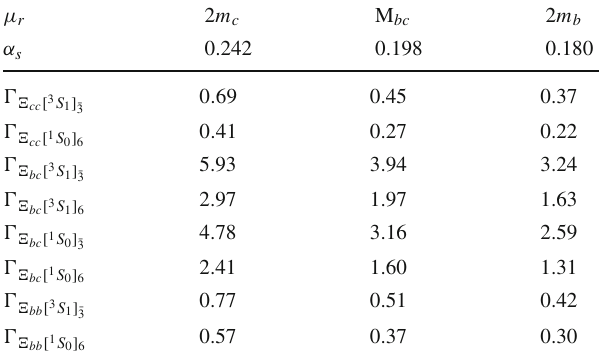
Table 7 The theoretical uncertainties for the production of baryons (cid:2) QQ (cid:3) via Higgs boson decays by substituting the renormalization scale